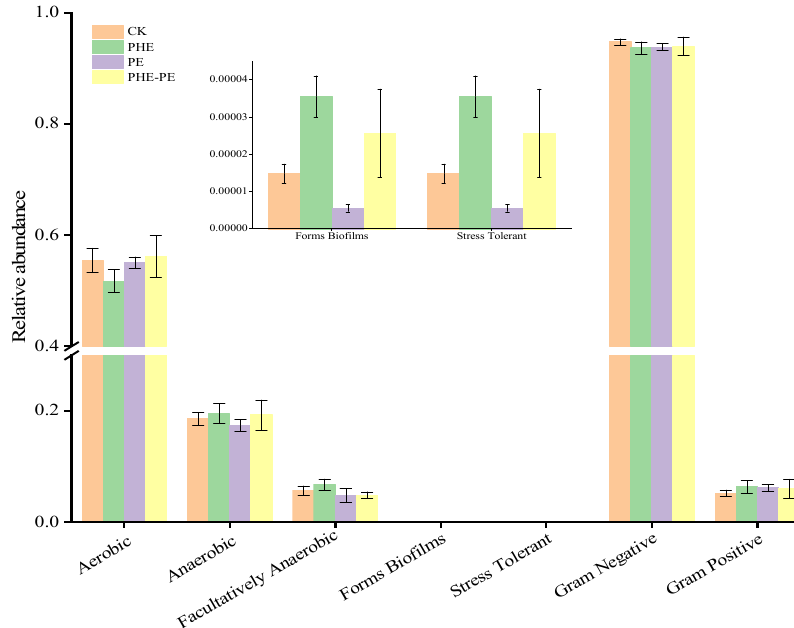
Figure 4. The prediction of bacterial community phenotypes based on BugBase.